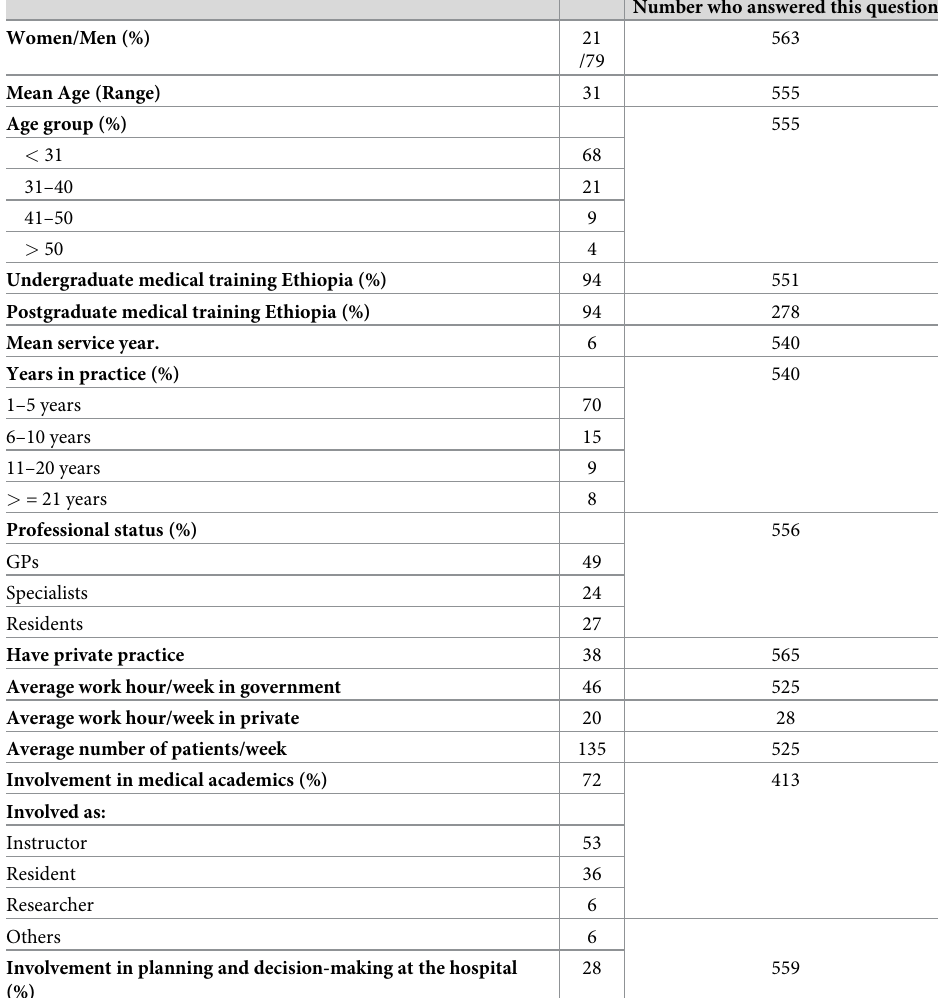
Table 2. Respondents characteristics. All respondents were government employed. Analysis done on valid N, excluding missing and not